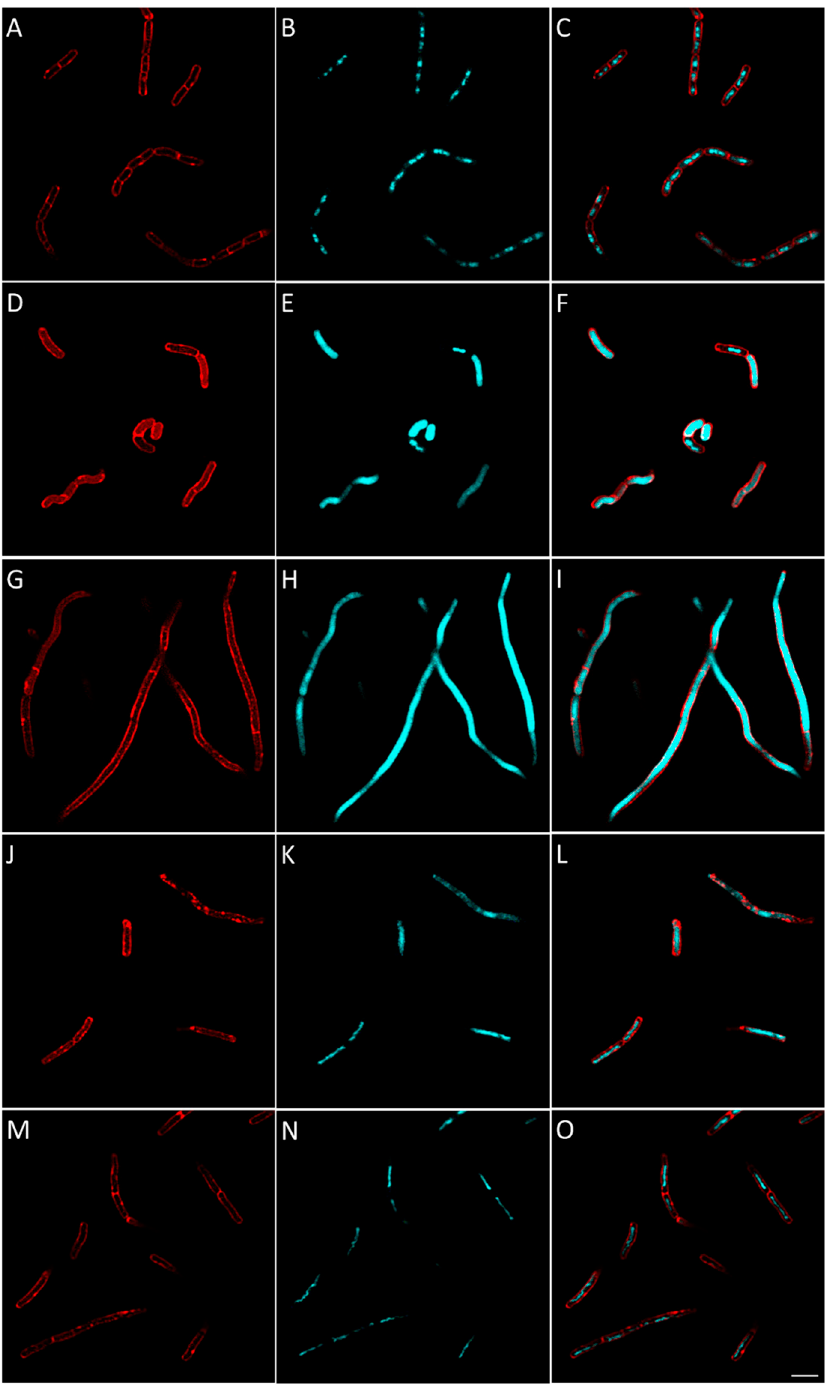
Figure 10. Morphological bacterial changes caused by conventional antibiotics in V. alginolyticus . Morphological changes of V. alginolyticus caused by conventional antibiotics were studied as explained in the Materials and Methods section. V. alginolyticus was incubated for 2 h at 37 °C in aerobic conditions with 4 × MIC of conventional antibiotics with known bacterial target. Control ( A – C ) was bacteria with no antibiotics added. Antibiotic used were: amoxicillin ( D – F ), inhibiting cell wall synthesis), gemifloxacin ( G – I ), inhibiting DNA synthesis), rifampicin ( J – L ), inhibiting RNA synthesis) and tetracycline ( M – O ), inhibiting protein synthesis). Images shown are representative of overall observed effects and correspond to bacterial membrane stained with FM4-64FX (red signal) ( A , D , G , J , M ), bacterial DNA stained with DAPI ( B,E , H , K , N ) and merged membrane and DNA signals ( C , F , I , L , M , O ). The white scale bar on the bottom right corner corresponds to 4 µm.